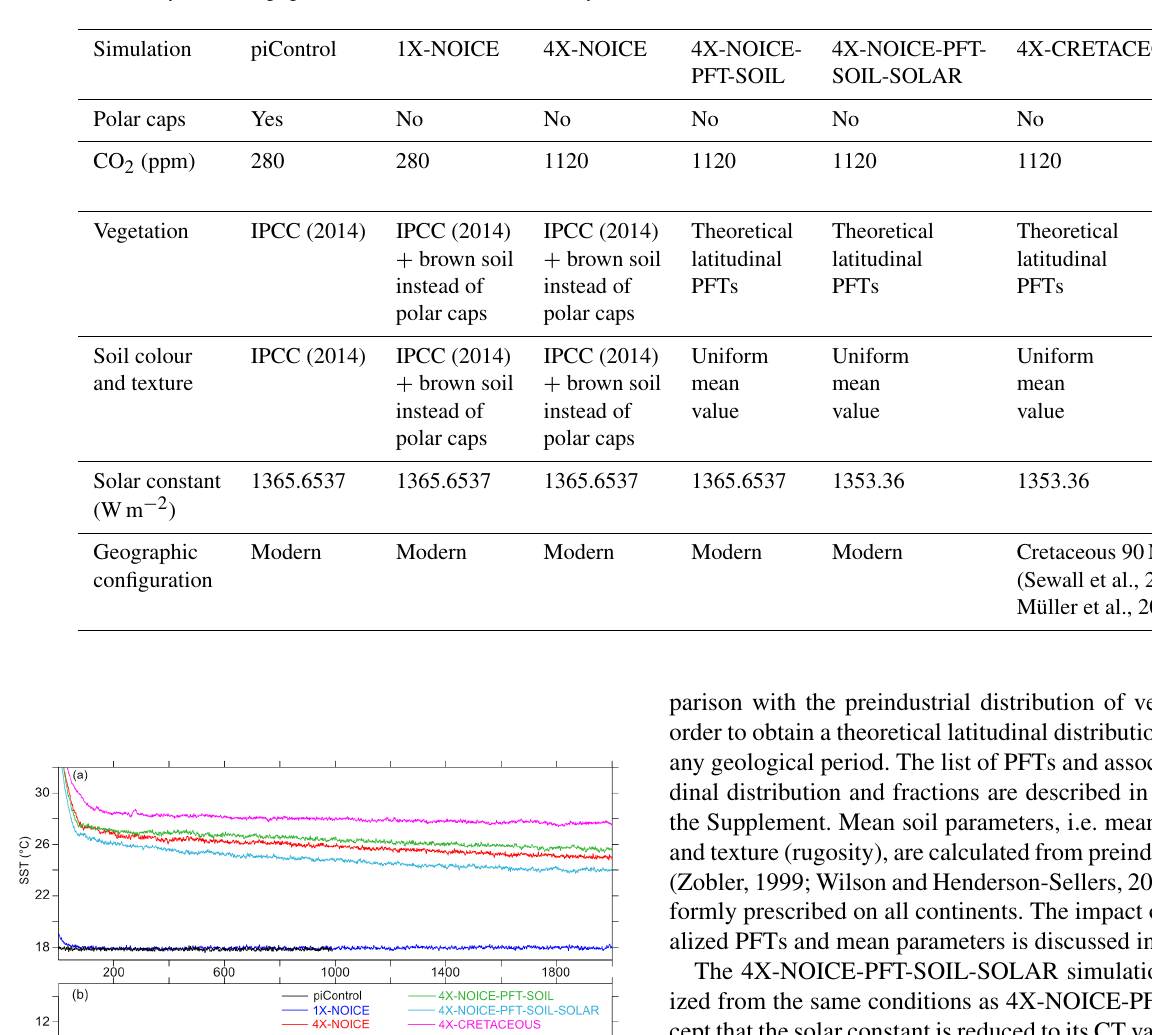
Table 1. Description of the simulations. The parameters in bold indicate the specific change for the corresponding simulation. Simulations are run for 2000 years, except piControl, which is run for 1000 years.